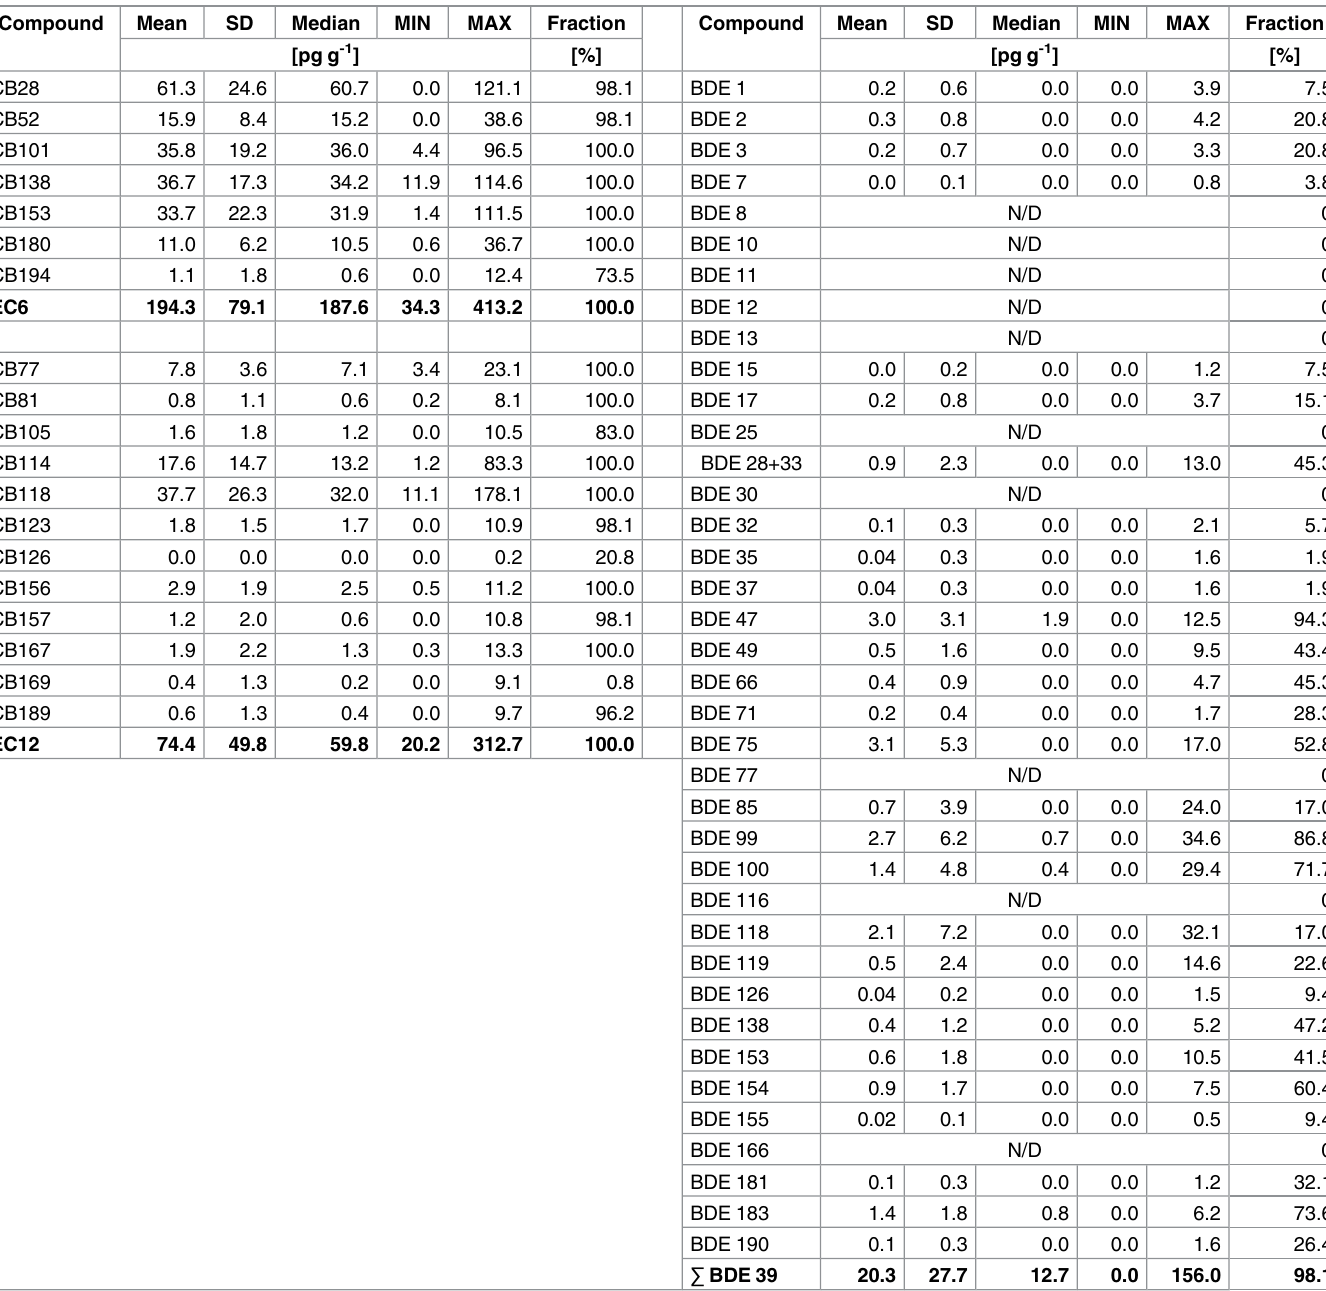
Table 3. Concentrations of PCBs/PBDEs found in the analyzed samples and fractions of PCB/PBDE-positive samples. Compound